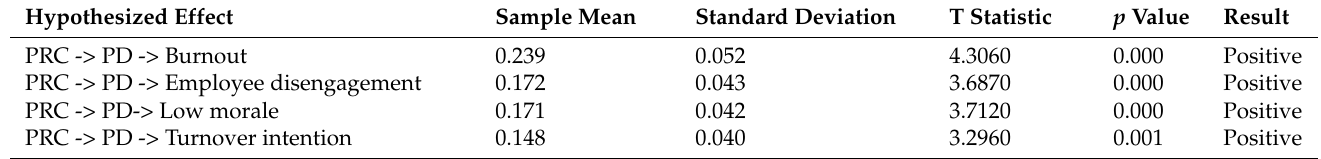
Table 5. Indirect mediation